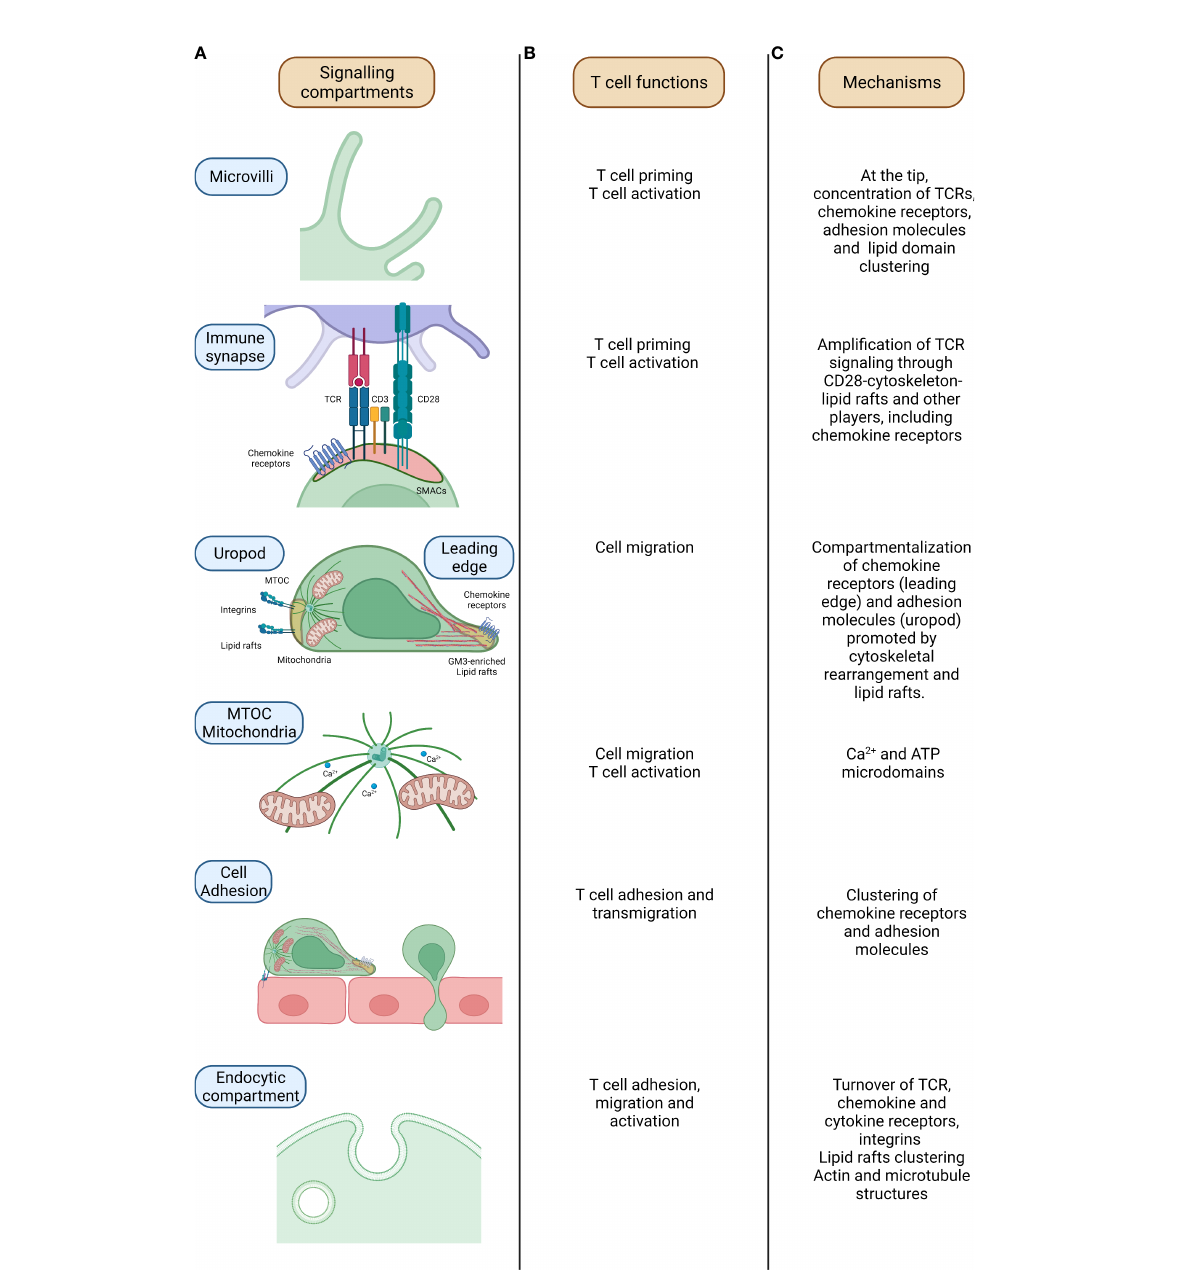
FIGURE 1 MechanismsofsignallingcompartmentalizationinTcells.Fromtheleft,relevantcompartmentswhichregulatesignallingcompartmentalizationinTcells (A) ,relatedTcellactivities (B) andmechanismsunderpinningsignallingcompartmentalizationatthesesitesareoutlined (C) .Inmicrovilli,parallelactin fi